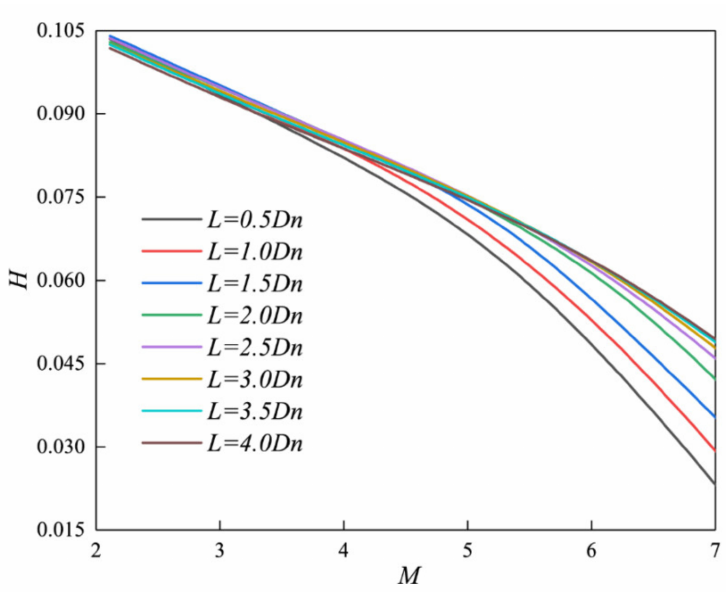
Figure 14. Operation curves at different mixing chamber lengths ( L = 0.5, 1.0, 1.5, 2.0, 2.5, 3.0, 3.5, 4.0 Dn